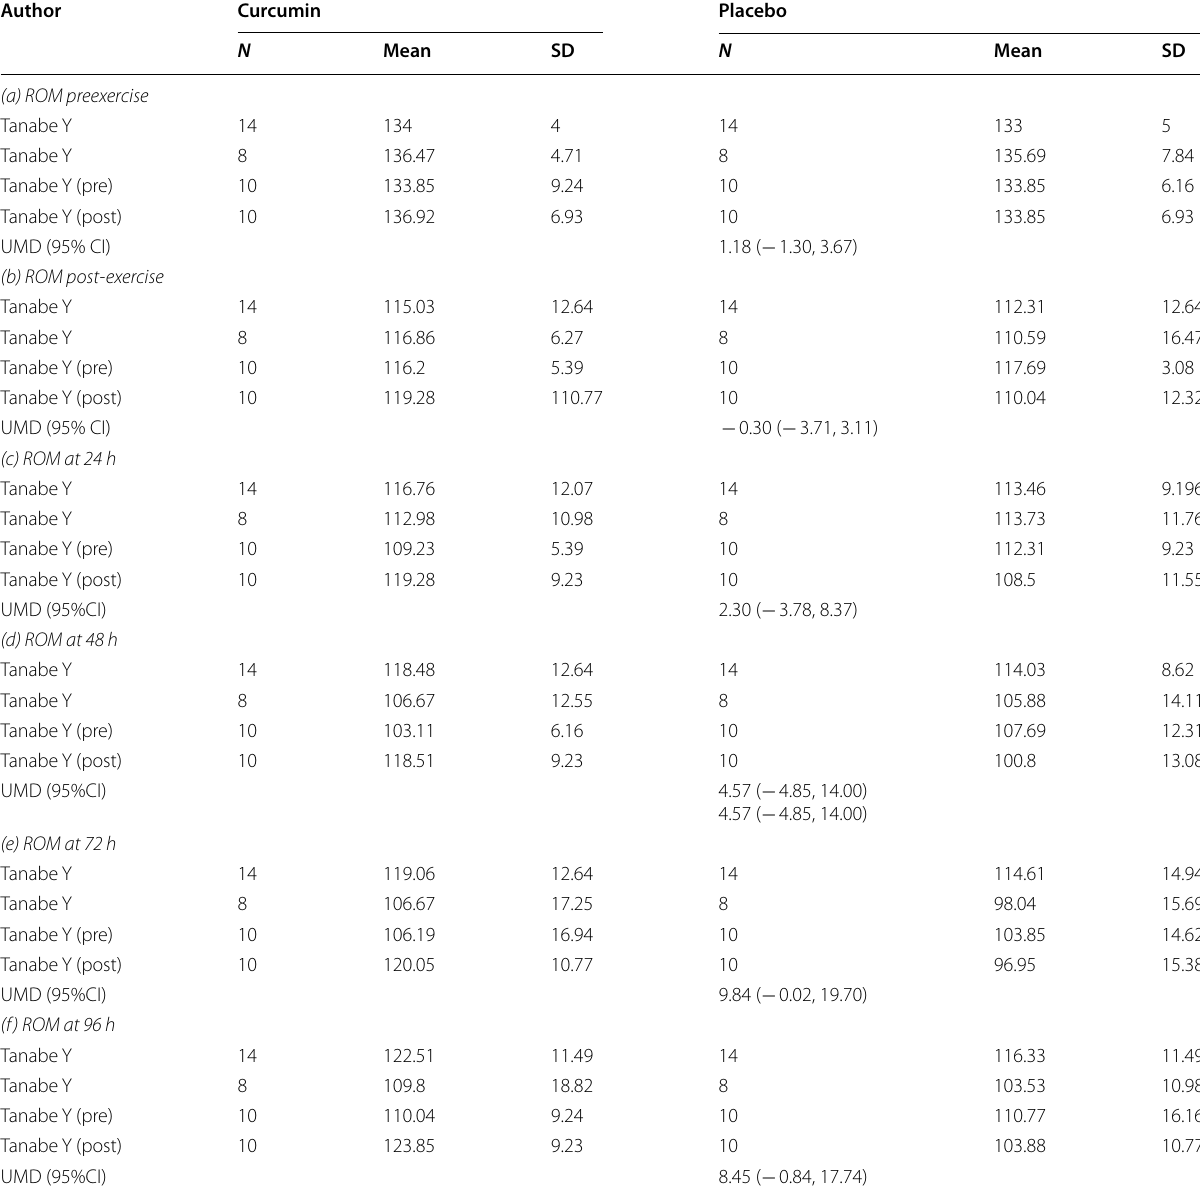
Table 7 Comparisons of ROM between curcumin supplement and placebo Author